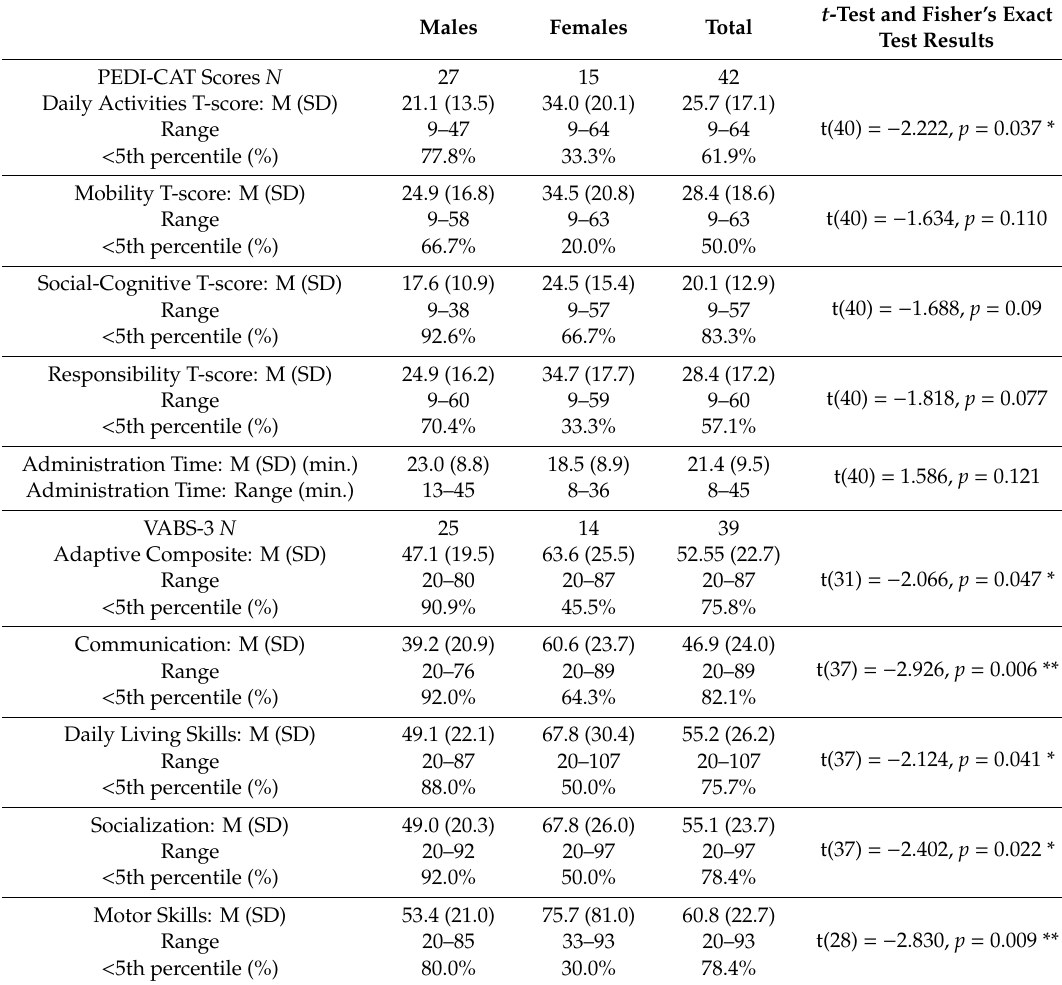
Table 1. Time 1 scores on the PEDI-CAT (Pediatric Evaluation of Disability Inventory- Computer Adaptive Test) and VABS-3 (Vineland Adaptive Behavior Scales-3rd Edition). t -Test and Fisher’s Exact Males Females Total Test